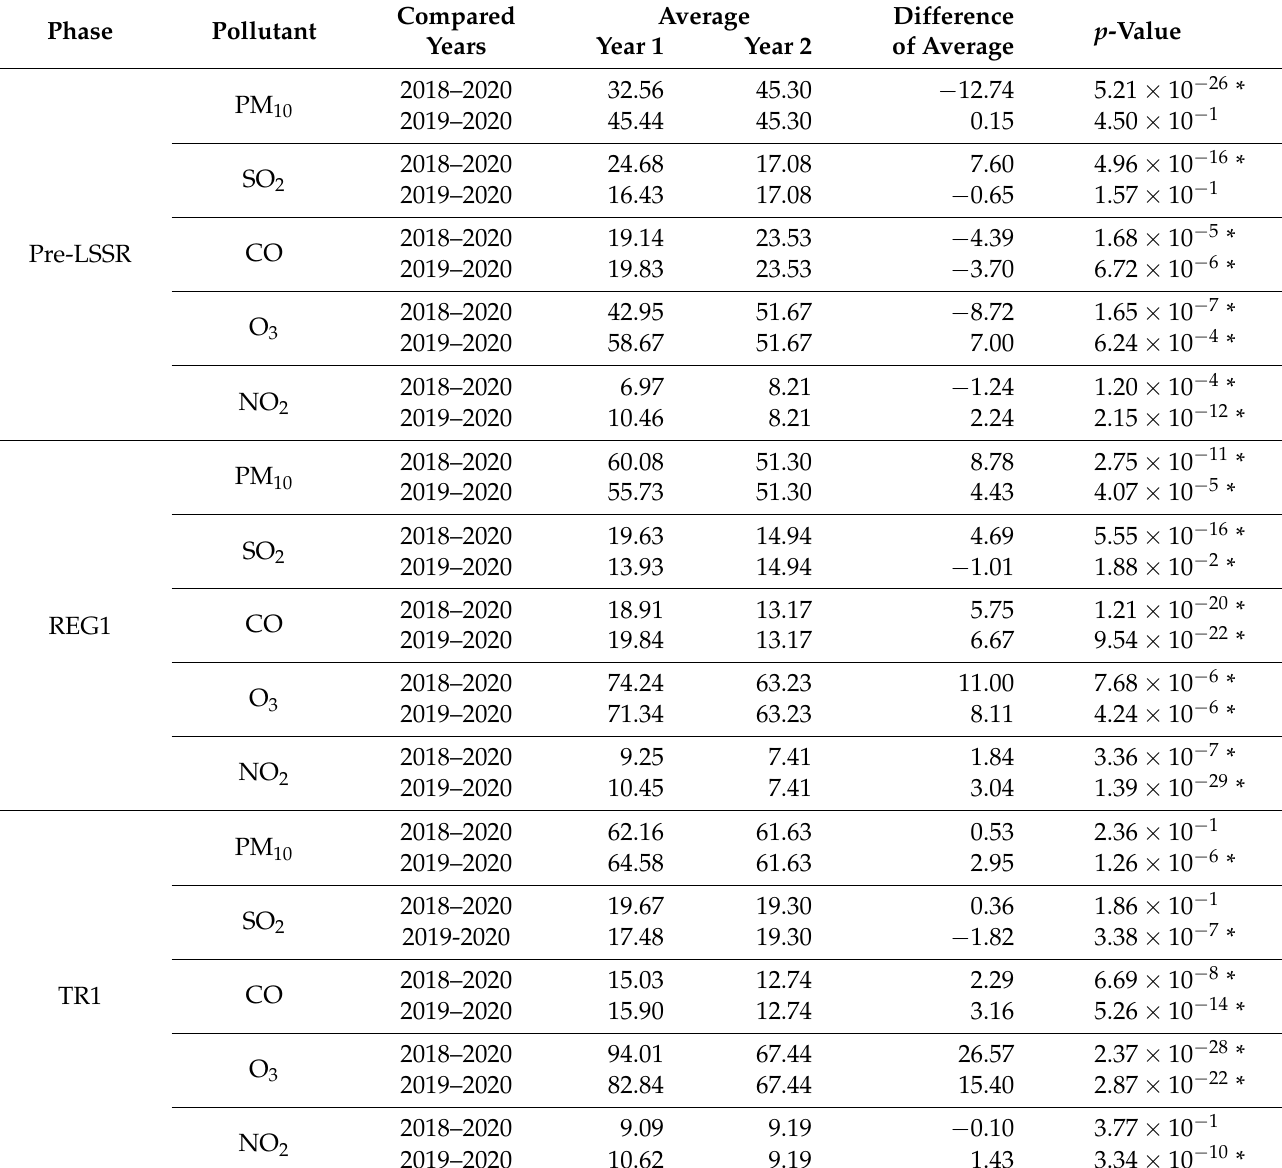
Table 6. The change of average AQI from 2018 and 2019 to 2020 of each pollutant within the Pre-LSSR, REG1, and TR1